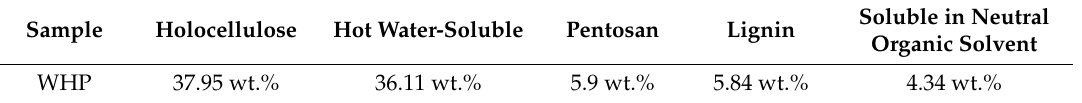
Table 2. Chemical characterization of Water Hyacinth (WH) petiole (WHP).